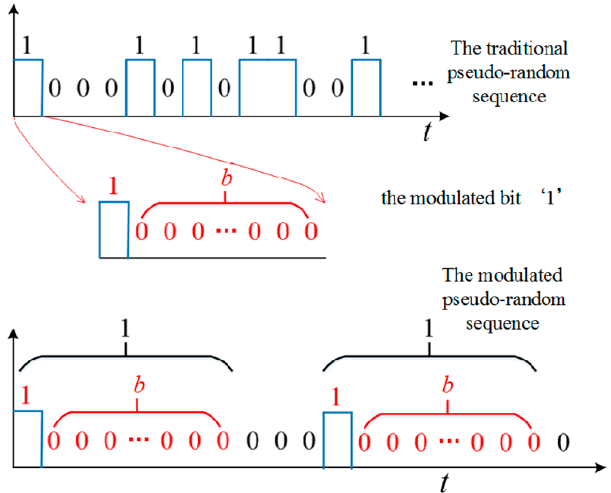
Figure 4. The schematic diagram of the modulated pseudo-random sequence.